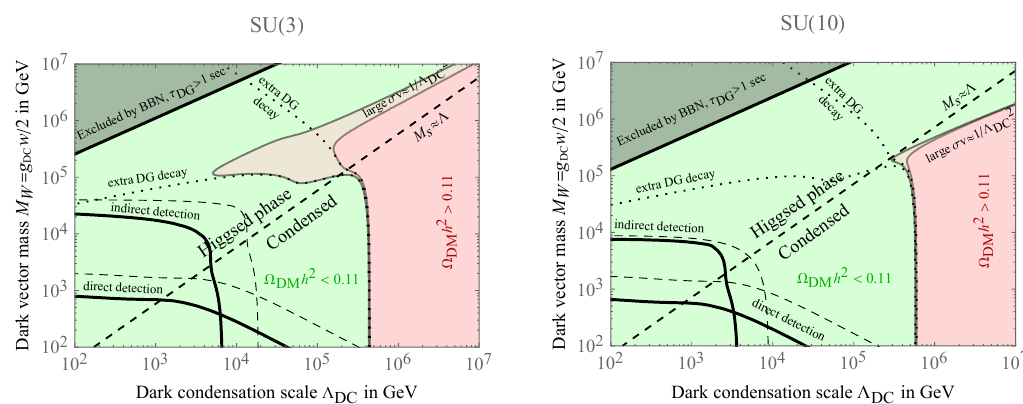
= W M ss m a o r ec t kv r D a